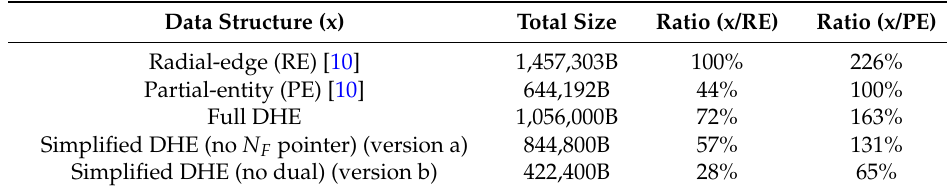
Table 3. Storage requirements for a cell complex of 1000 cubes (10 ˆ 10 ˆ